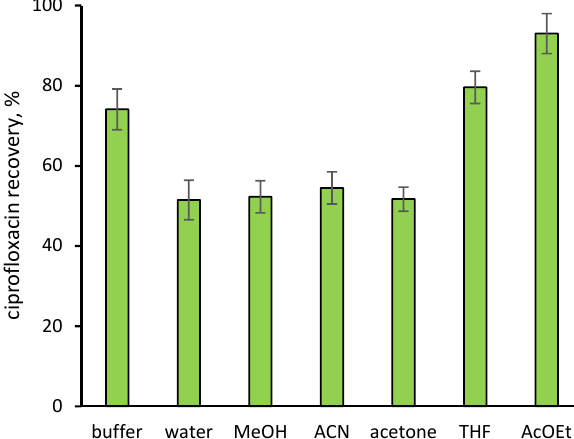
Figure 3. Effect of 1 mL of washing solutions on retention of ciprofloxacin after loading of 1 mL of synthetic urine containing 200 ng mL − 1 of ciprofloxacin, diluted 9 + 1 v / v with 50 mmol L − 1 MES buffer, pH 4.5.